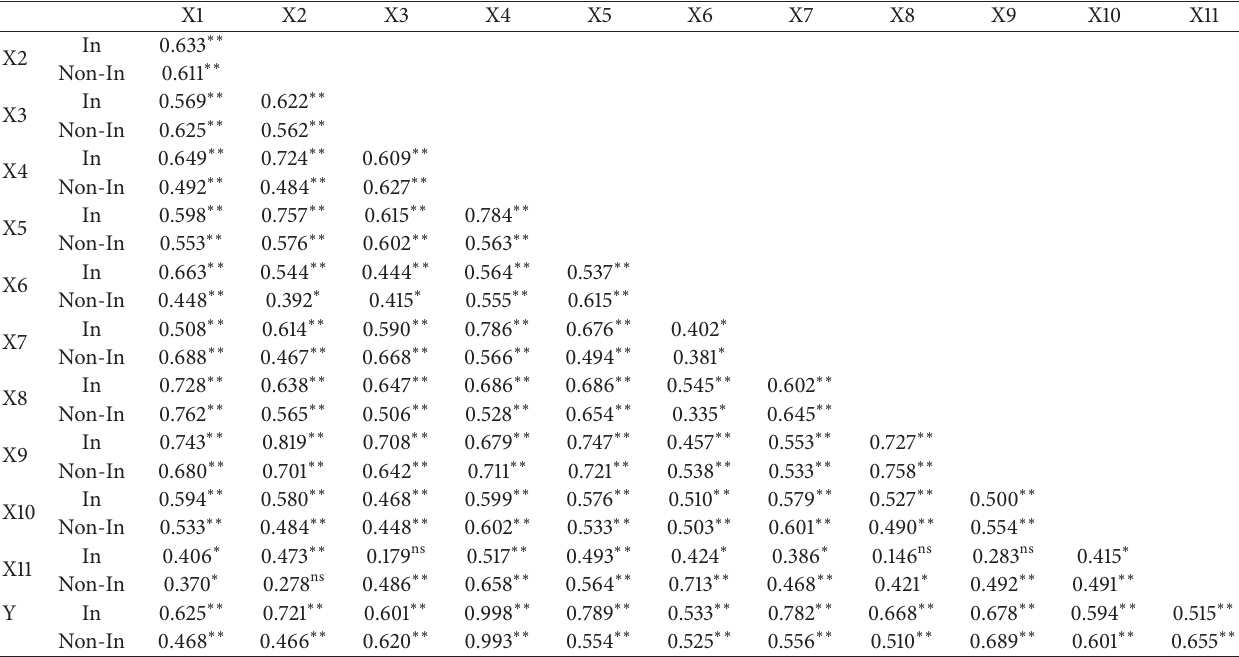
Table 2: A matrix of simple correlation coefficients ( 𝑅 ) for the measured variables of wheat under inoculation (In) and noninoculation (non-In) conditions and different water levels.